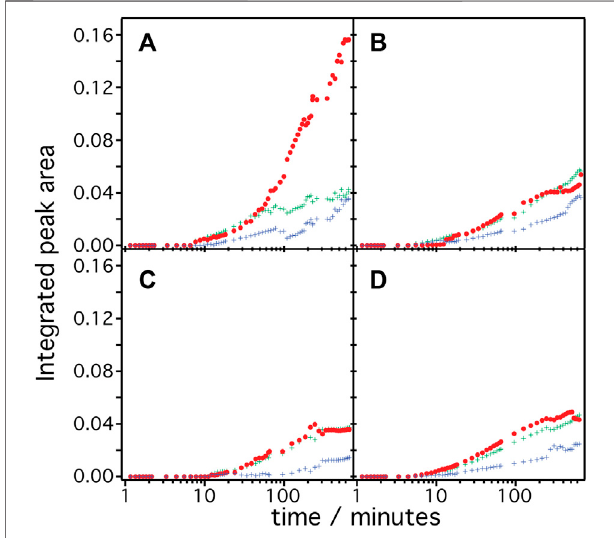
FIGURE4| Integratedpeakareaofthesecondarystructurecontribution over time during the cell-free expression of (A) Hs BR, (B) Cr ChR2, (C) Hs SRI, and (D) Hs SRII areshown.Thecolorcoderepresentsthecontributionfrom α - helices (red), bend/misfolded (green) and random (blue)